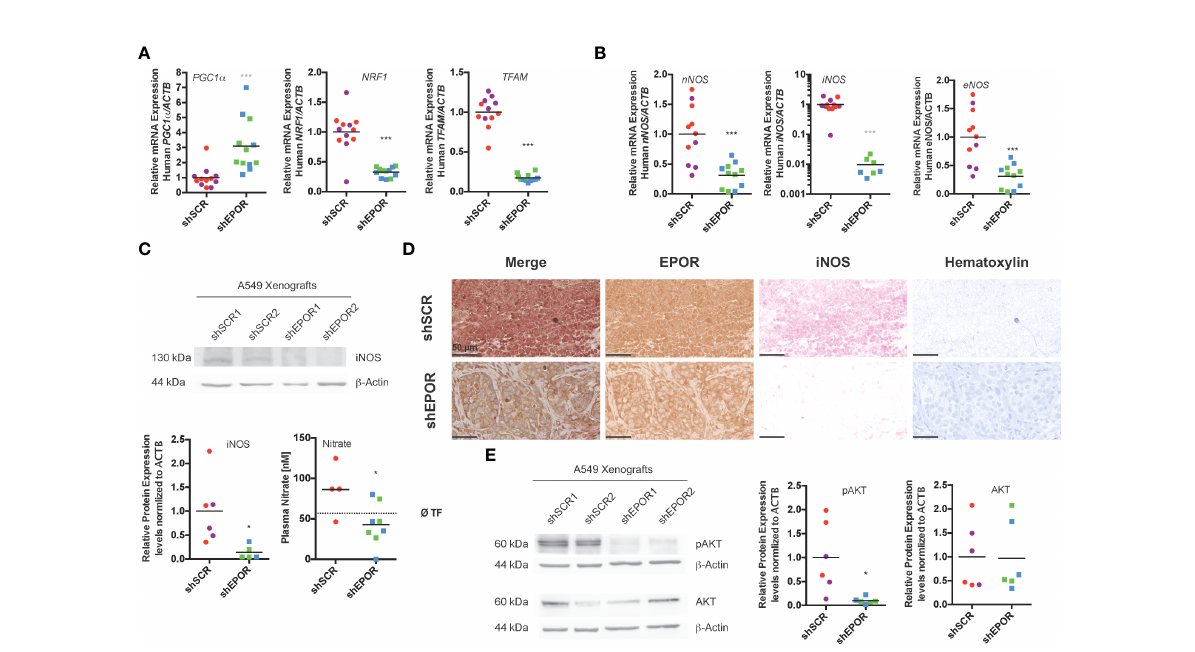
FIGURE 4 Knockdown of EPOR impairs iNOS expression and AKT phosphorylation in A549 lung cancer xenografts in Foxn1nu mice. Biopsies of human A549 tumors expressing EPOR (shSCR1/2) or not (shEPOR1/2) were isolated from Foxn1nu mice, and levels of key mitochondrial biogenesis, as well as nitric oxide synthesis genes and proteins, were quanti fi ed by qPCR and western blotting. (A) Shown are the human mRNA levels of mitochondrial biogenesis genes peroxisome proliferative activated receptor, gamma, coactivator 1 a ( PGC-1a ), nuclear respiratory factor 1 ( NRF1 ) and transcription factor A, mitochondrial ( TFAM ) quanti fi ed by qPCR and normalized to b -actin ( ACTB ) mRNA expression levels (n=12). Panel (B) shows the mRNA levels of nitric oxide synthase genes nNOS, iNOS , and e NOS from control (shSCR) and EPOR-knockdown (shEPOR) tumors quanti fi ed by qPCR and normalized to b -actin ( ACTB ) mRNA (n=6-12). Notably, iNOS mRNA was not detectable in fi ve samples (two from clone shEPOR1 and three from shEPOR2), and the scale is logarithmic. Panel (C) shows representative western blot images of iNOS (130 kDa) from protein extracts of control tumors (shSCR) and EPOR-knockdown tumors (shEPOR) (n=3). b -actin (44 kDa) was used as a loading control. The band intensities of proteins after western blotting images were quanti fi ed using MCID Analysis 7.0 and normalized to b -actin. The relative protein expression levels of iNOS are shown for control (shSCR) and EPOR- knockdown (shEPOR) tumors (n=6). Furthermore, the plasma nitrate values of mice with shSCR and shEPOR tumors are shown (right panel). The dotted black line indicates the reference value for three tumor-free Foxn1nu mice (n=4-7). (D) Tumor sections of control (shSCR1) and EPOR-knockdown (shEPOR1) tumors were immunohistochemically stained for EPOR (brown) and iNOS (pink) and counterstained with hematoxylin (blue). Panel (E) shows a representative western blot image of phospho-AKT (60 kDa) and AKT (60 kDa) from protein extracts of control tumors (shSCR) and EPOR-knockdown tumors (shEPOR) (n=3). b -actin (44 kDa) was used as a loading control. The band intensity of proteins on western blotting images was quanti fi ed using MCID Analysis 7.0 and normalized to b -actin. Relative protein expression levels of pAKT and AKT are shown for control (shSCR) and EPOR-knockdown (shEPOR) tumors (n=6). Data are presented as scattered blots with the mean and individual data distribution of each clone (shSCR1 purple, shSCR2 red, shEPOR1 green, and shEPOR2 blue tumor samples). Data